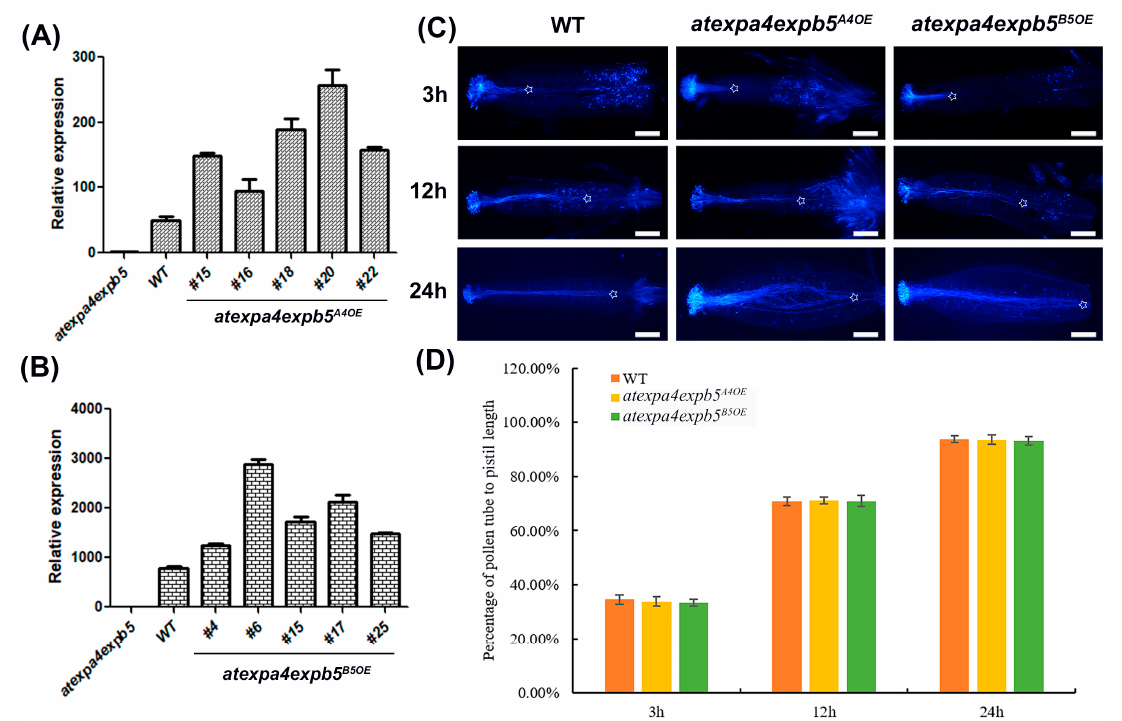
Figure 5. AtEXPA4 or AtEXPB5 can complement the slow pollen tube growth. ( A , B ), qRT-PCR analysis of AtEXPA4 ( A ) or AtEXPB5 ( B ) expression in 35-d-old inflorescences from atexpa4expb5 , atexpa4expb5 A4OE , and atexpa4expb5 B5OE . BETA-TUBULIN4 was used as the reference gene, and expression in atexpa4expb5 was normalized to 1. The values are the mean ± SD, three biological replicates with three technical replicates in each biological replicate. ( C ) Aniline blue staining of pollen tubes at 3 h, 12 h, and 24 h after pollination, hours (h). Asterisks show positions where pollen tubes arrive, scale bars, 300 μ m. ( D ) the percentage of pollen tube to pistil length in ( C ). Values are means, error bars are SD, n = 7 pistils per replicate, three biological replicates.